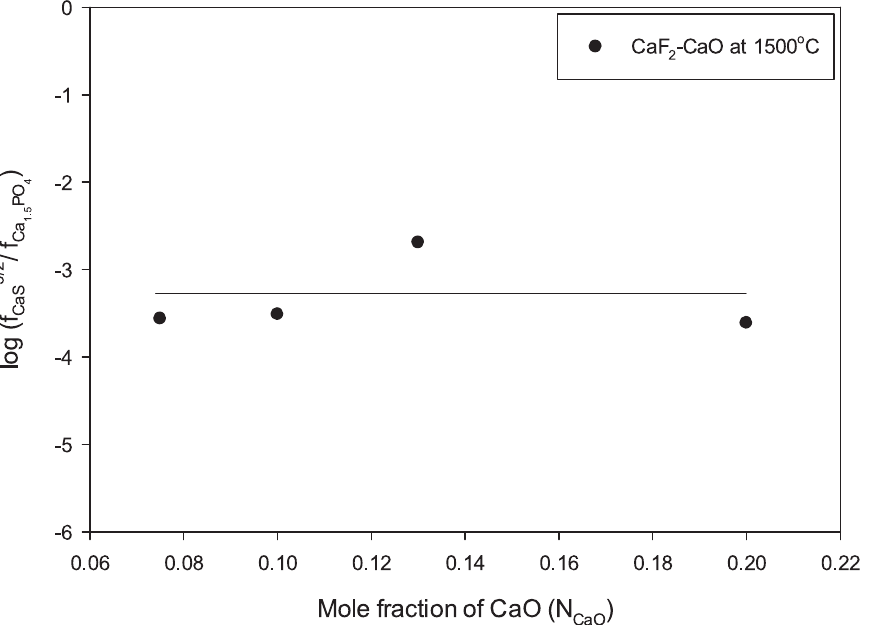
3/2 (( ) / ) Fig. 2: Variation of CaS Ca PO f f with mole fraction of CaO in CaF 2 -CaO slags at 1500 °C. The phosphate and sulphide capacities data 1.5 4 were taken from references [4] and [30],